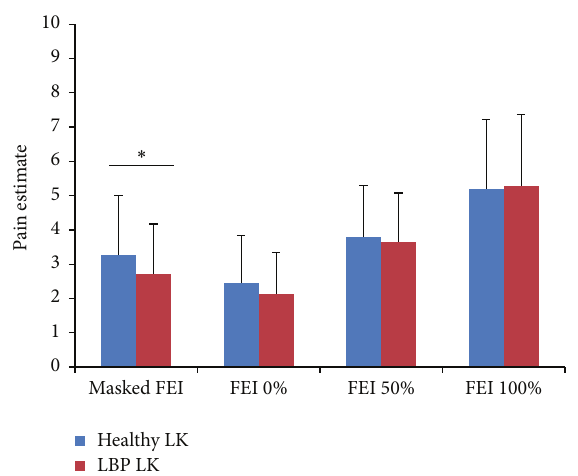
Figure 4: Means and standard deviations for each level of facial expression intensity (FEI) and lumbopelvic kinematics (LK). Only significantLKeffectsareillustratedwithastar(seethetextfordetails regardingFEIeffectsforeachlevelofLKconditions).Note: ∗ 𝑝 < .05 .